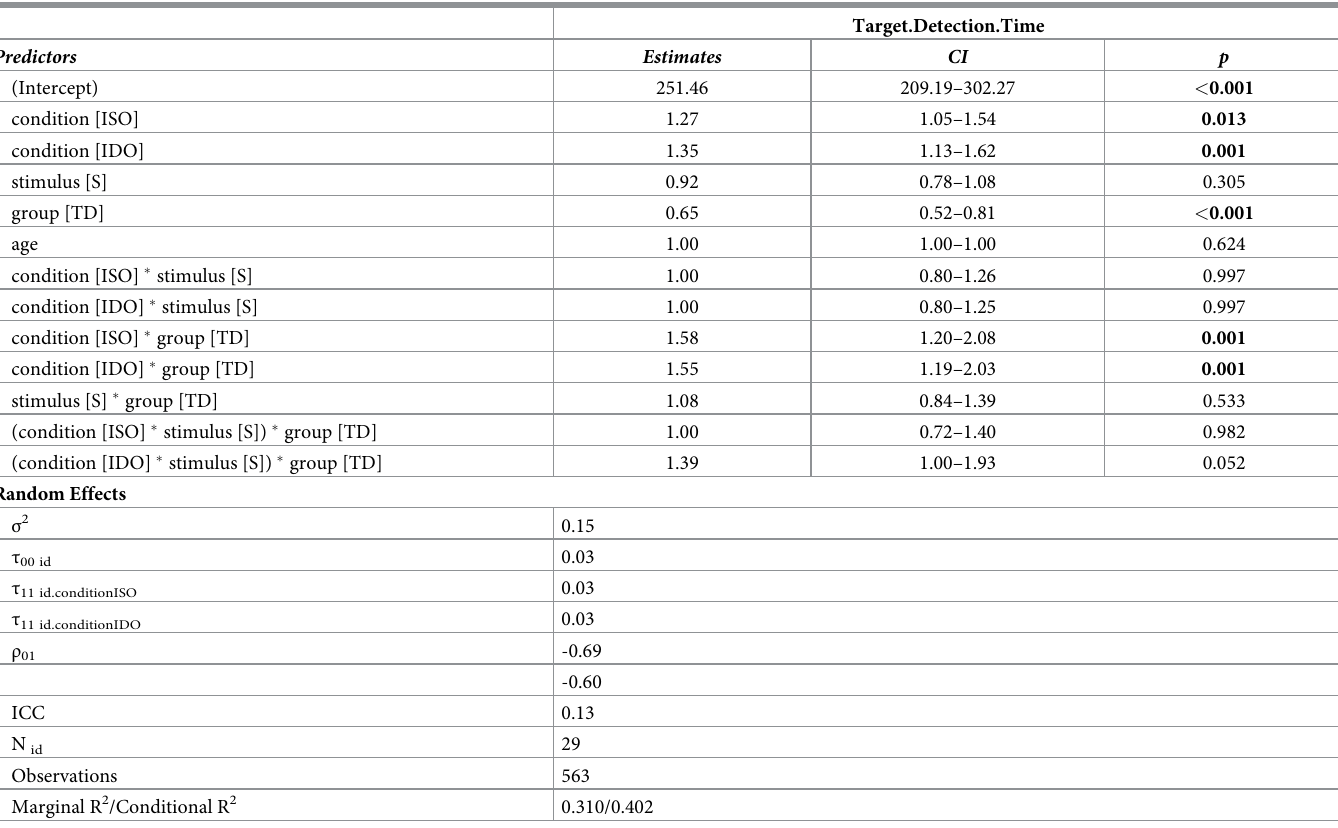
Table 2. Estimated linear regression coefficients,95% confidence intervals and p-value associated with each predictor of the best-selected model